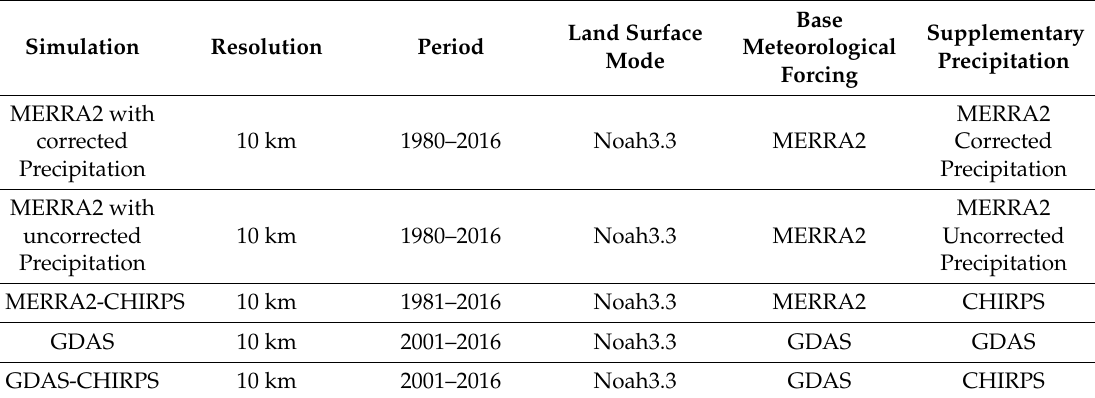
Table 1. Details about the model simulations used in this